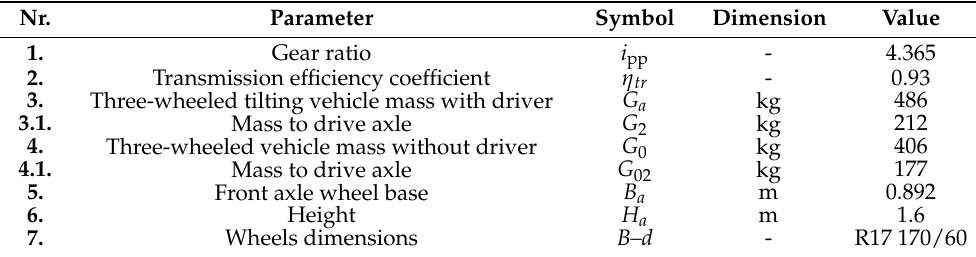
Figure 2. Electric motor HPM-2000 power and torque parameters [38]. Table 1. Three-wheeled vehicle